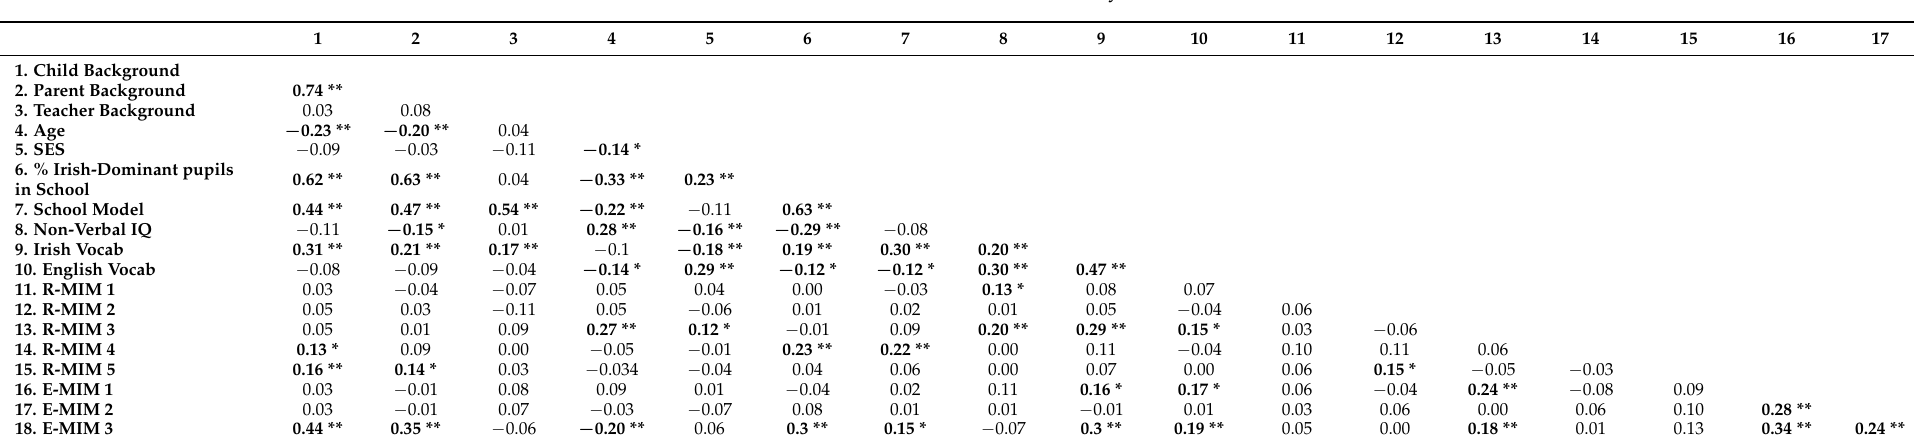
Table A1. Intercorrelations between study